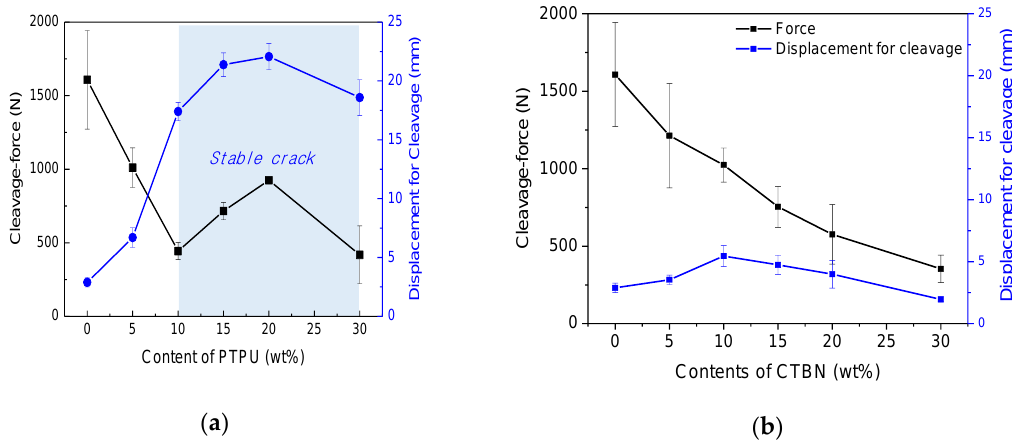
Figure 7. Cleavage-force ( ■ ) and displacement for cleavage ( ● ) of the PTPU-toughened ( a ) and CTBN-toughened ( b ) epoxy adhesives.